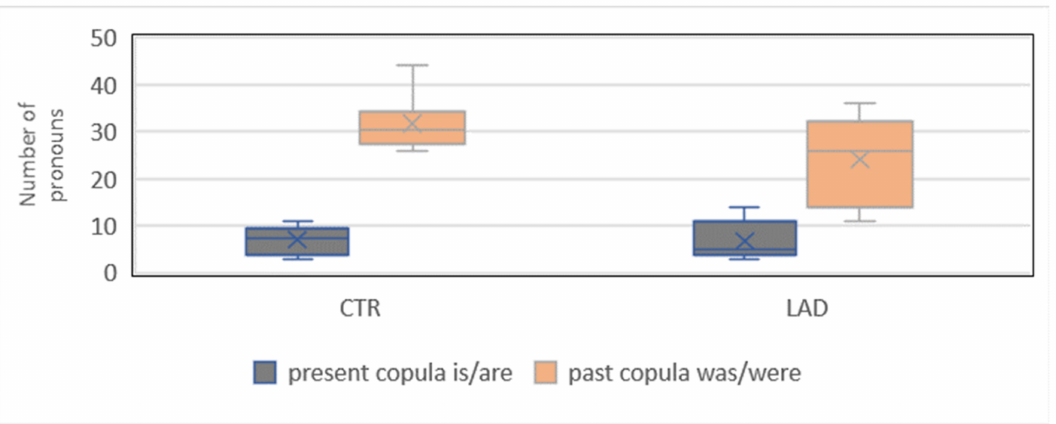
Figure 10. Proportion of propositional pronoun das + present tense copula and + past tense